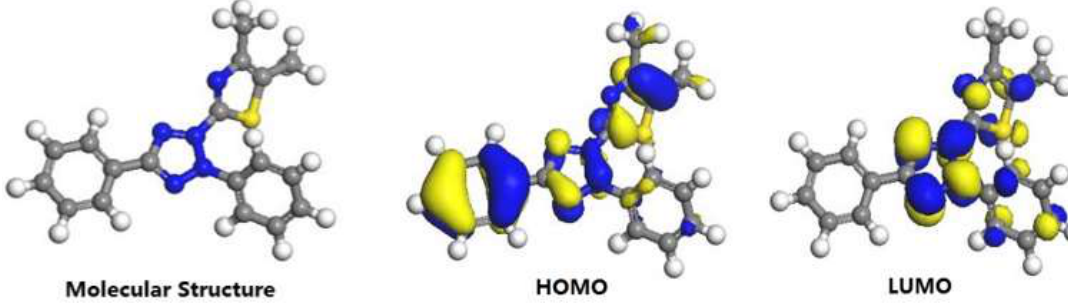
Figure 11. Optimized geometric structure and the frontier molecular orbital for the MTT cation.